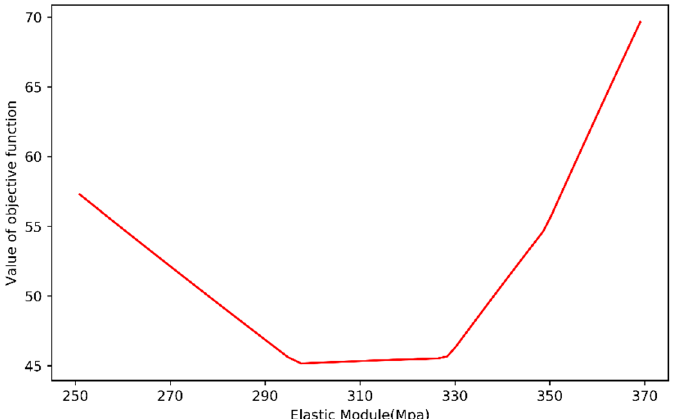
Figure 10. The objective function value L changes with the value of the equivalent elastic modulus.